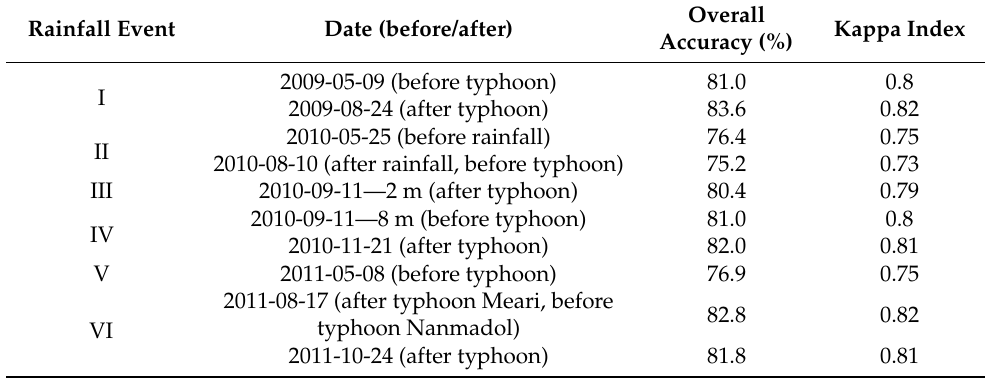
Table 5. Summary of interpretation results of satellite images before and after